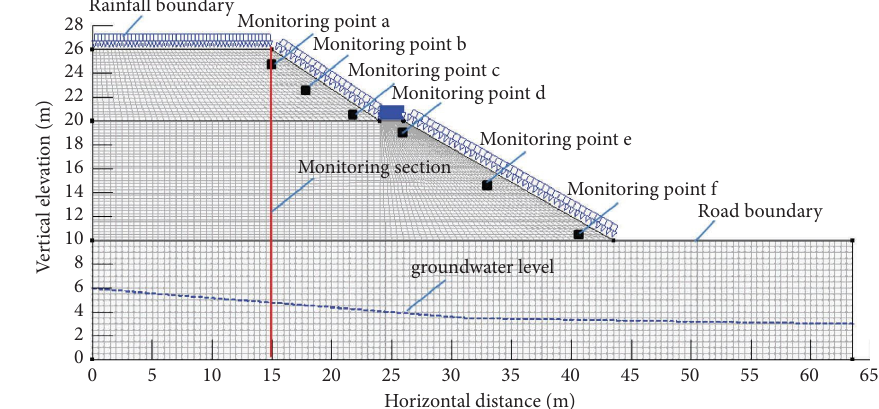
Figure 2: Seepage numerical model. Table 1: Physical parameters of granite residual soil.